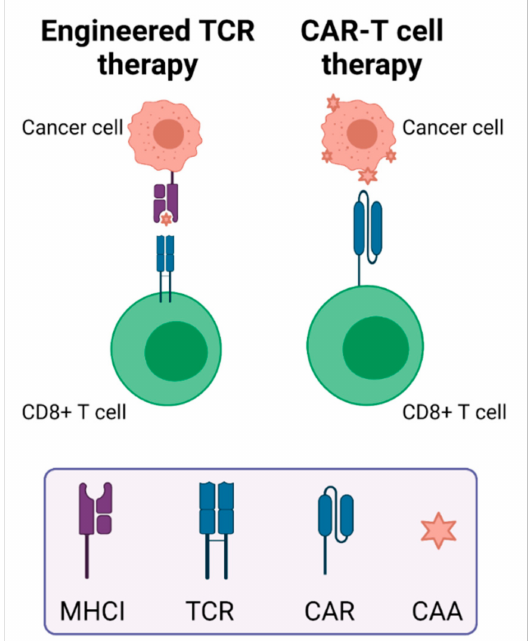
Figure 2. Engineered TCR therapy vs. CAR-T cell therapy. Engineered TCR T cell therapy involves engineering T cells with receptors that are specific for MHC class I-presented antigenic peptides. CAR-T cell therapy involves direct recognition of CAAs on the cancer cell surface. CAA, cancer- associated antigen; CAR, chimeric antigen receptor; MHCI, major histocompatibility complex class I; TCR, T cell receptor. Created in